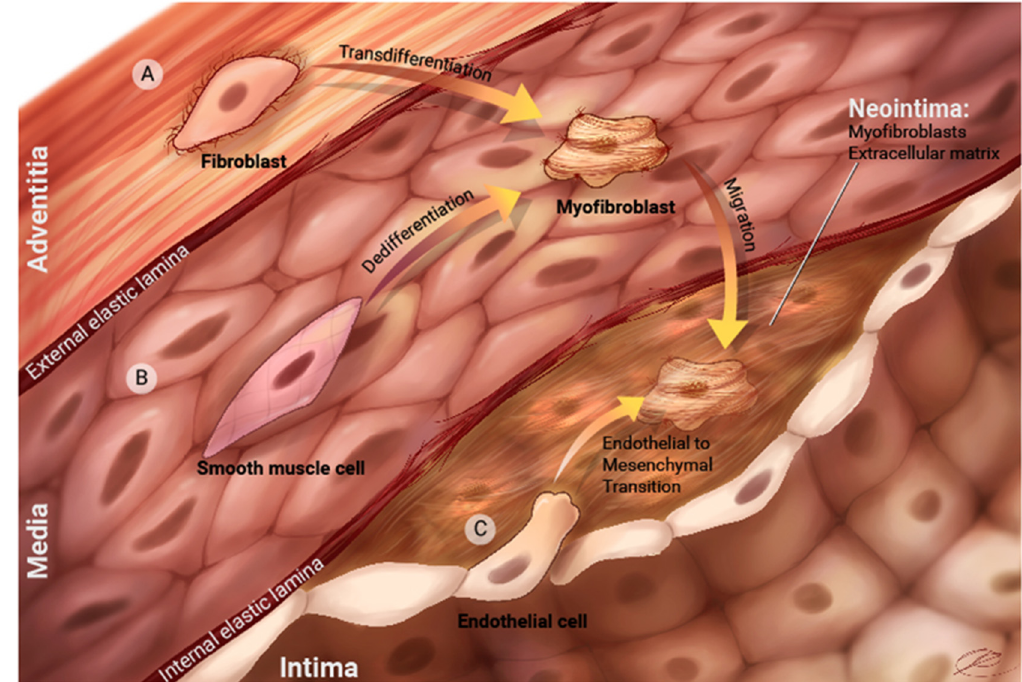
Figure 2. Potential sources of myofibroblast-like cells in pulmonary vein stenosis. Potential sources of cells could be through proliferation of existing pericytes and fibroblasts in the various vascular compartments ( A ), dedifferential of smooth muscle cells ( B ), endothelial-to-mesenchymal transition ( C ), and circulating progenitors cells. (Reprint permission, RD Vanderlaan, PVS Network, www.PVSNetwork.org, accessed on 1 May 2021).